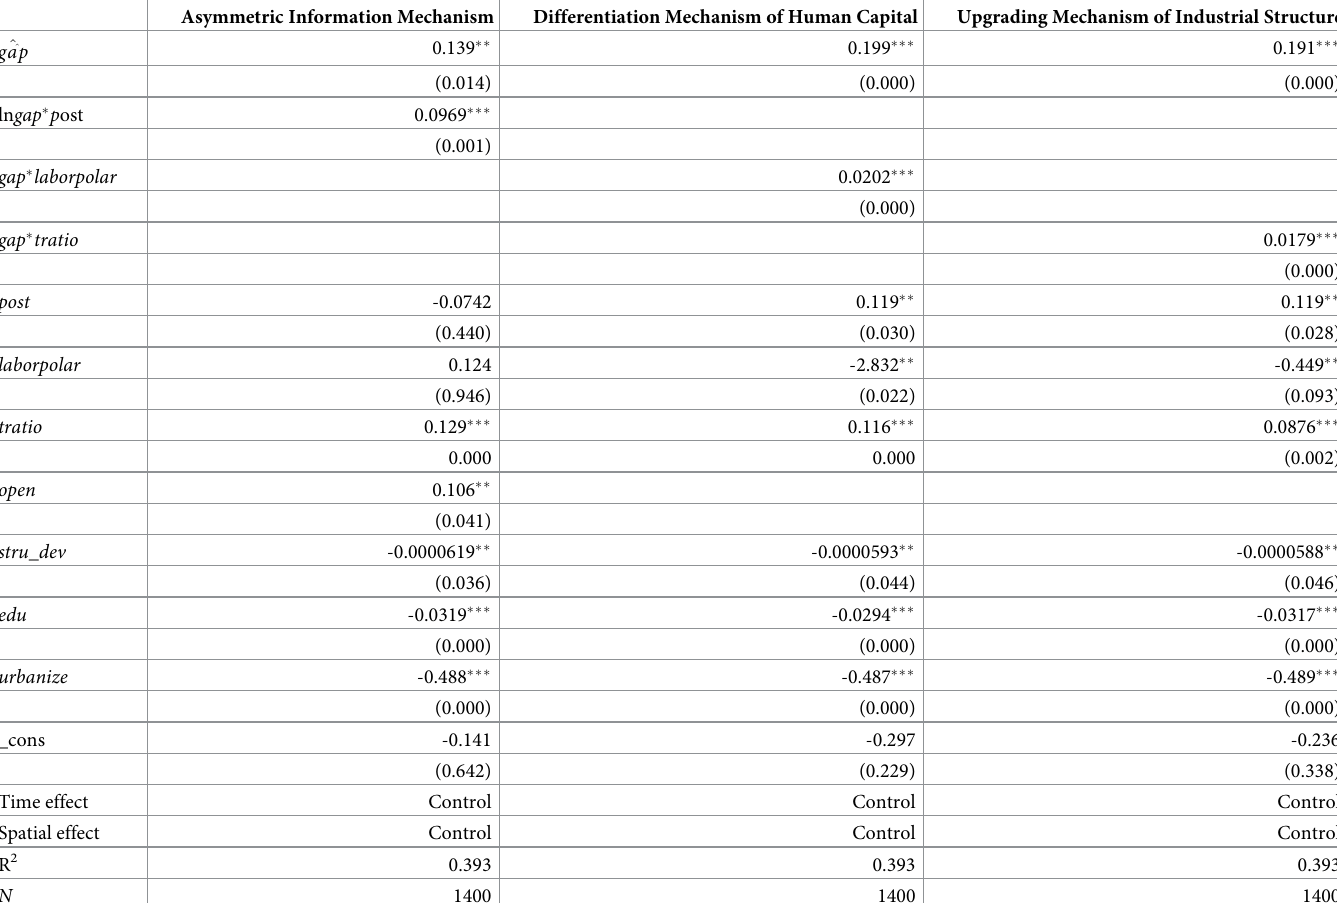
Table 11. Mechanisms